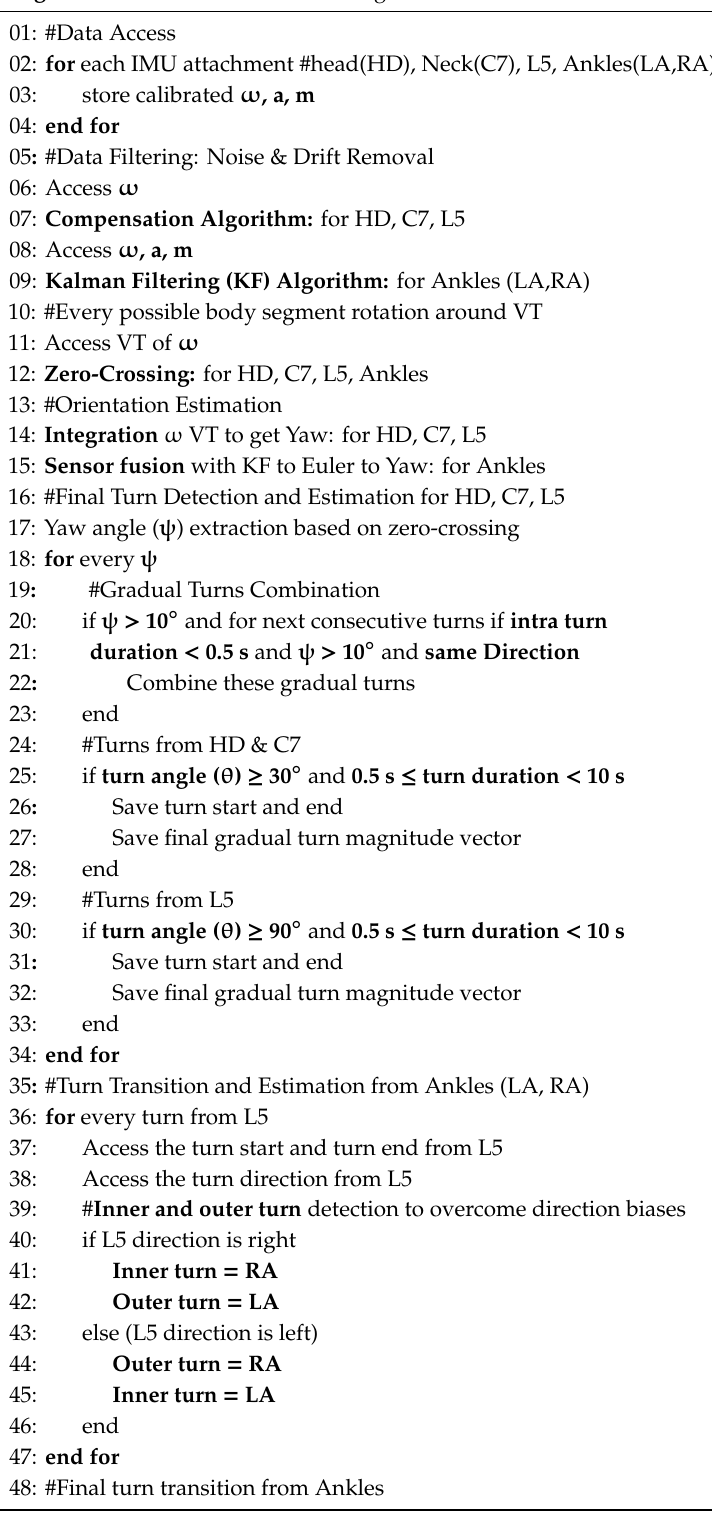
Algorithm 1. Pseudo code for turning start and end